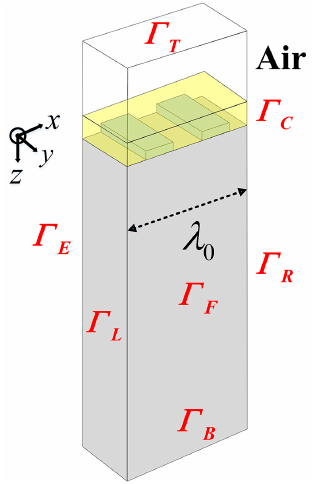
Figure 8. The schematic of a layered periodic model with embedded electrodes.